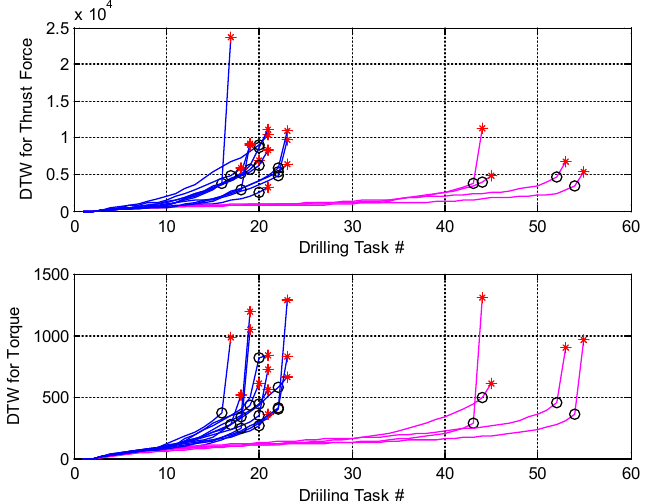
Figure 2. Feature calculation using dynamic time warping (DTW) with thrust Force (upper figure) and torque (lower figure) with multiple drill-bits. Blue lines represent drill-bits which lasted less than 30 drilling tasks, and pink lines represent those which lasted more than 30 drilling tasks. Red stars indicate the instance of failure ( x -axis: drilling task number) or the last drill task a drill bit undertook but